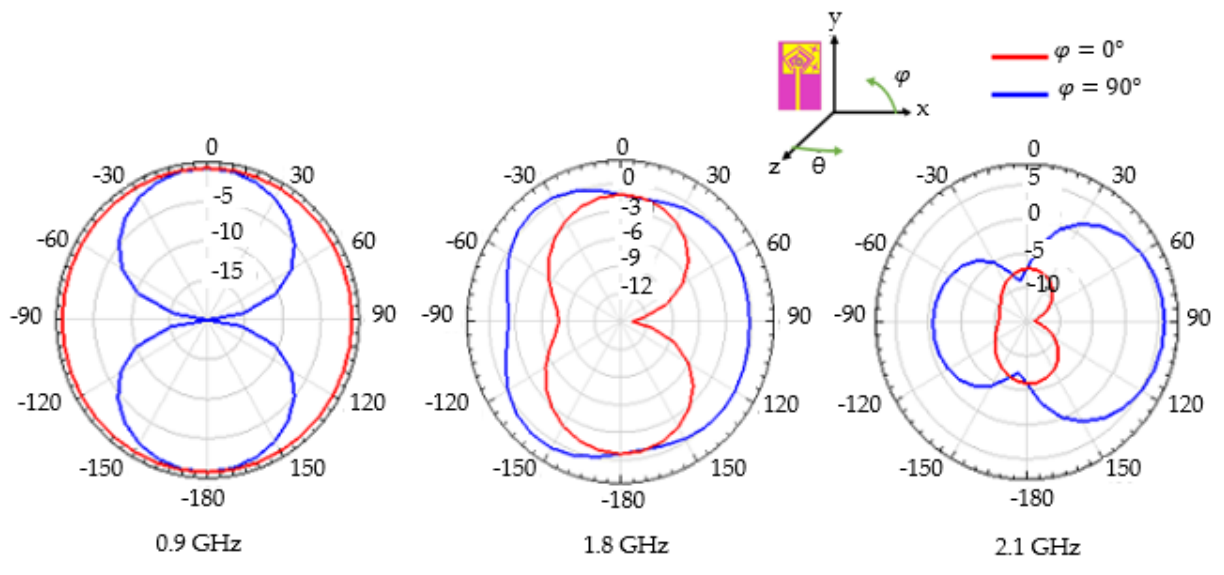
Figure 6. Simulated 2D radiation pattern of the far-field tri-band antenna gain for the three operating frequencies: 0.9, 1.8 and 2.1